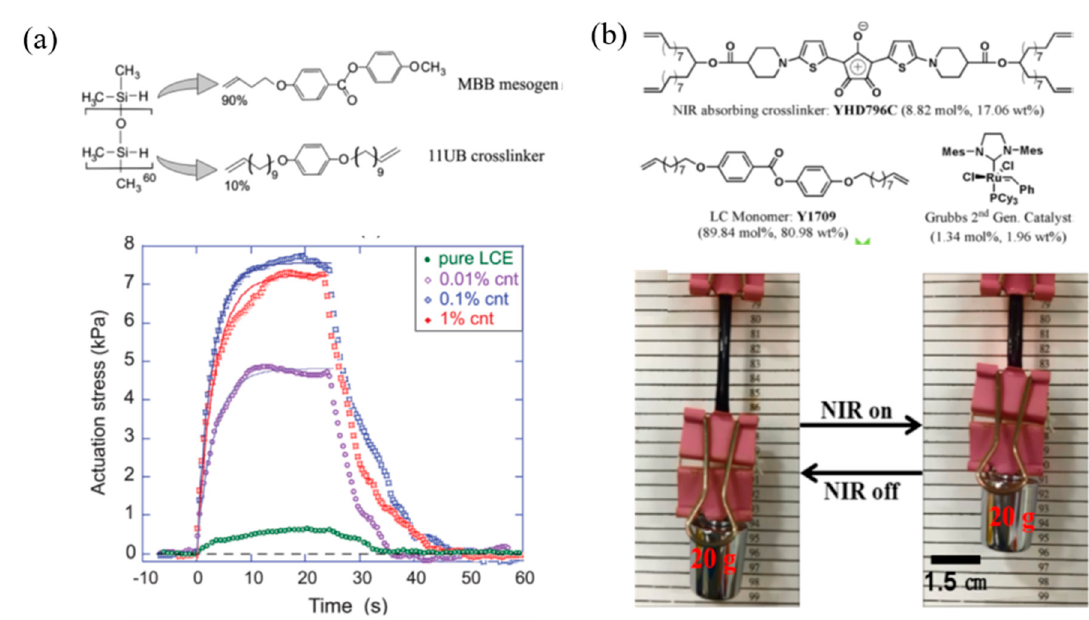
Figure 5. Photo responsive LCPs based on photo-heat effect. ( a ) An actuation stress measured by Iso-strain geometry on carbon nanotubes (CNTs) / LCPs composites irradiation with infrared light [71]. ( b ) The chemical structures of near-infrared spectroscopy (NIR) chromophore and LC monomers. A LCP film lifts up a load under NIR illumination irradiation. Reprinted with permission from [67]. Copyright (2017) American Chemical Society.